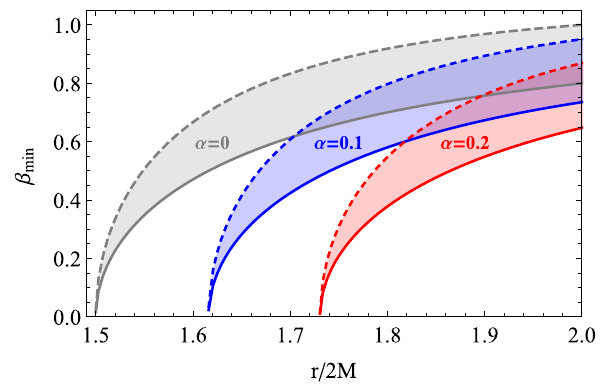
Fig. 4 The radial dependence of minimal value of specific angular momentum of the magnetized particle for the different values of the α parameter